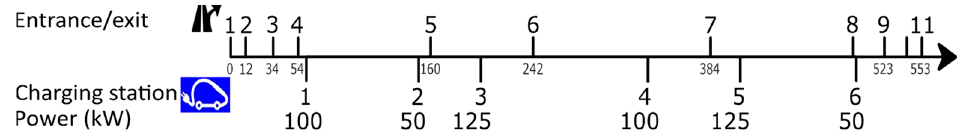
Figure 7. Highway characteristics. Figure 7. Highway Table 1. Studied vehicles.